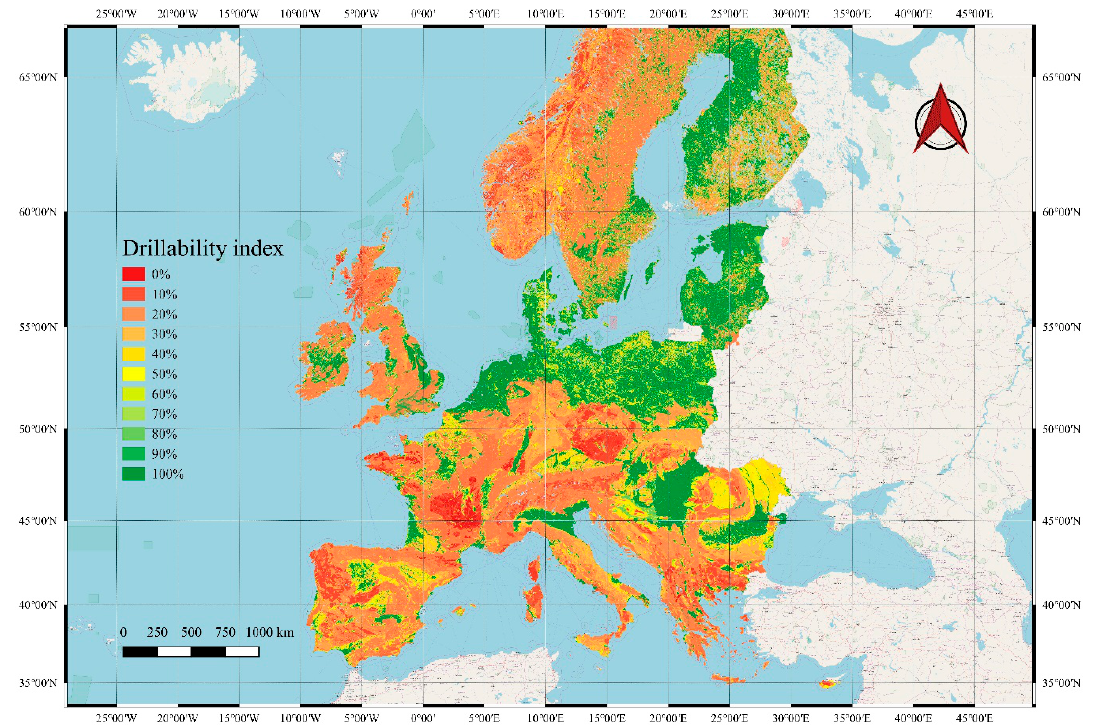
Figure 3. Percentage probability of suitable conditions for drilling in Europe.